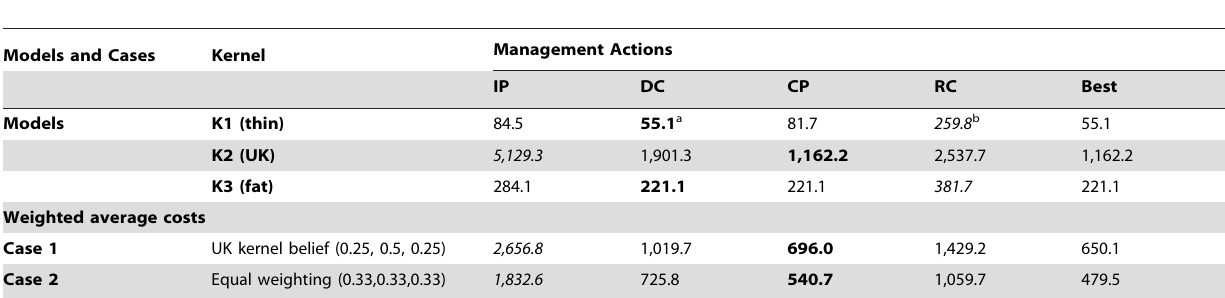
Table 2. The costs for the four strategies (IP only [IP], IP + DC [DC], IP + DC + CP [CP], IP + DC + 3 km ring culling [RC], when the FMD model is simulated with the dispersal kernels K1, K2, and